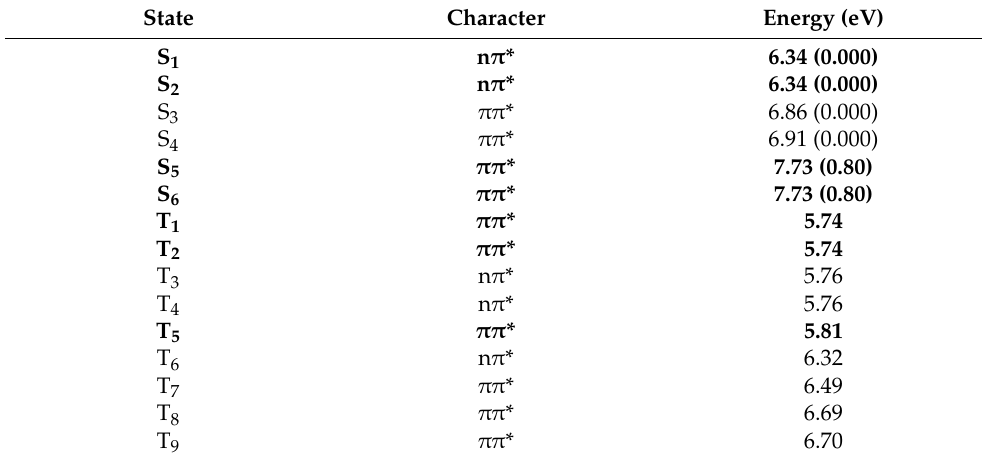
Table 1. Vertical excitation energies for the lowest six singlet and nine triplet states of microsolvated CA calculated at the TD-CAM-B3LYP/C-PCM/def2-TZVP//X3LYP/C-PCM/cc-pVDZ in water. States expected to play a plausible role in the electronic relaxation mechanism are highlighted in bold.